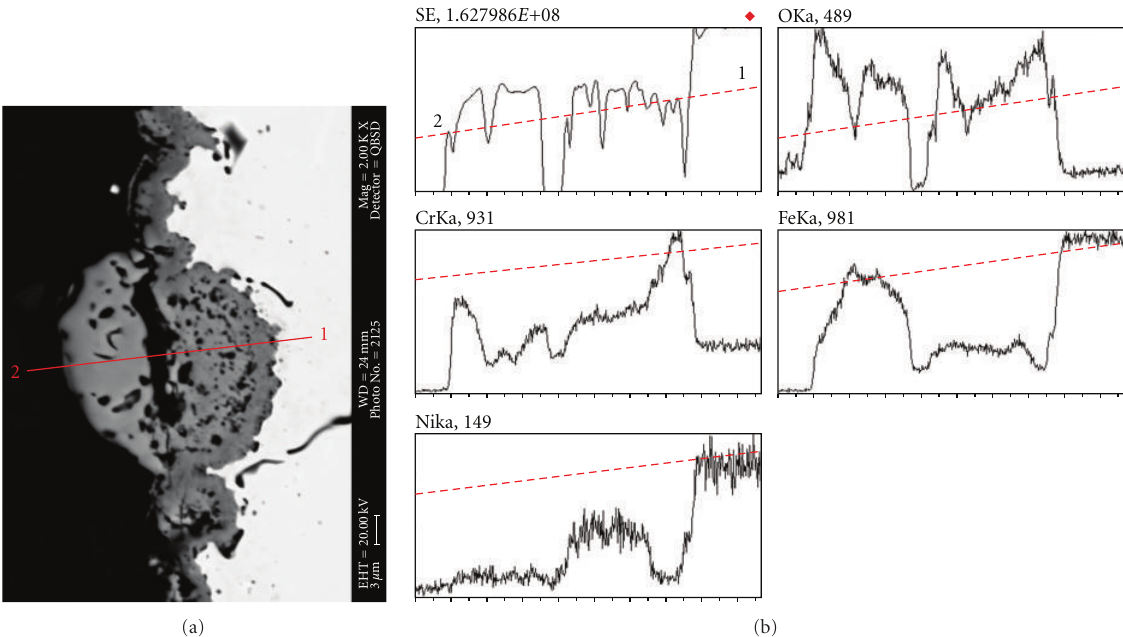
Figure 10: (a) SEM micrograph of the cross-section of the AISI 316 stainless steel oxidized at 1000 ◦ C for 100 hours and (b) XRD mapping analysis of the line